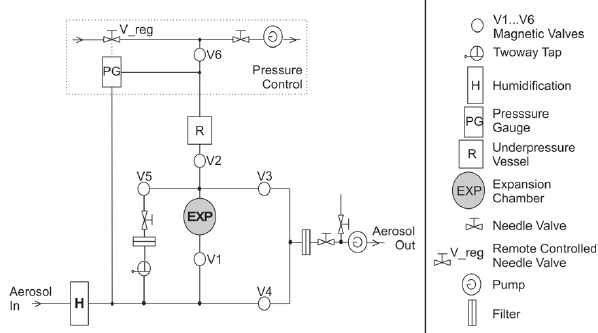
Fig. 6. Schematic diagram of the expansion cloud chamber showing the main components846 for pressure and flow control.847 Some of the fundamental complexities of trace gas uptake by condensed phase systems851 have been outlined in Section 2, above. The question arises - can theoretical analyses and852